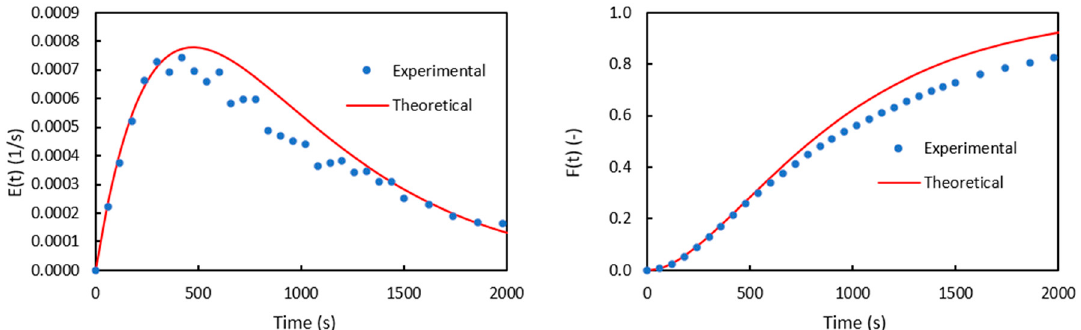
Figure 6. Experimental and simulated E ( t ) ( left ) F ( t ) ( right ) curves for Test 3.